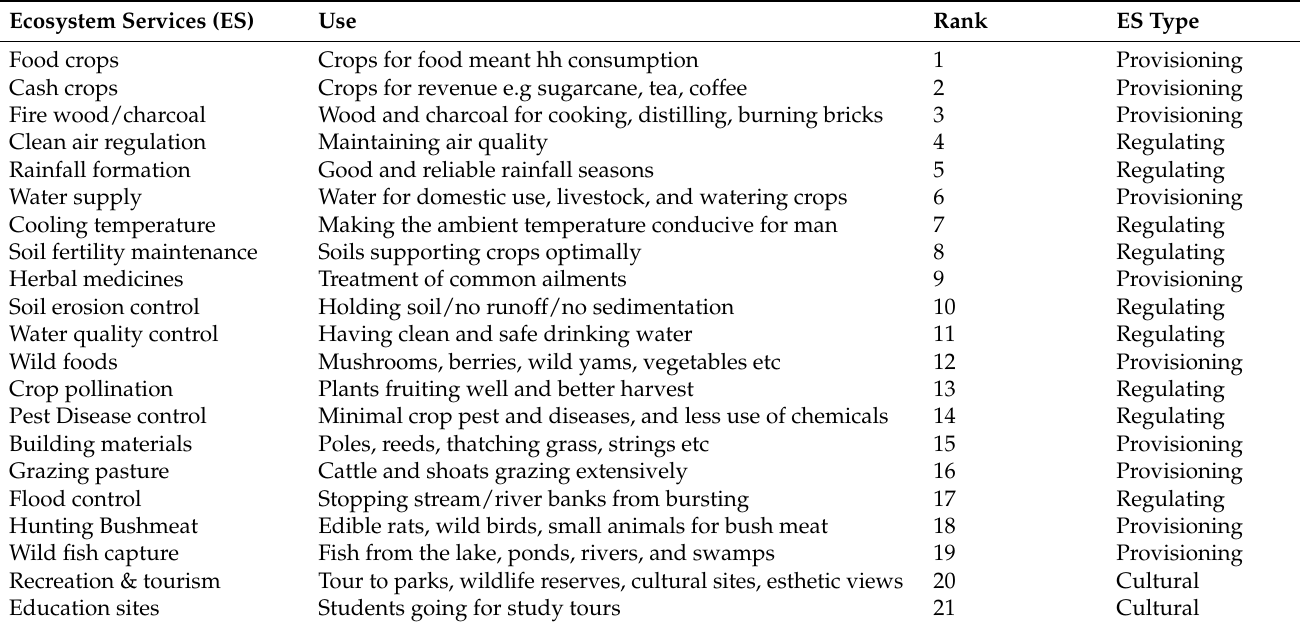
Table 2. Priority ecosystem services in the order of